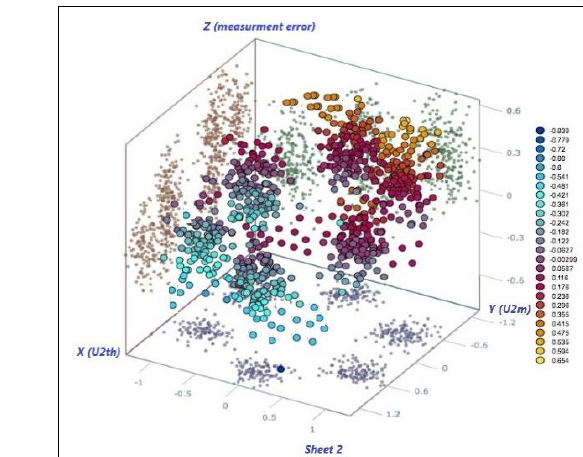
Figure 7. Processing data of Table 2 as measured velocities/flow. The plots display the clustering process related to electrical and flow quantities. Sheet 1 ( left ) depicts a major clustering versus sheet